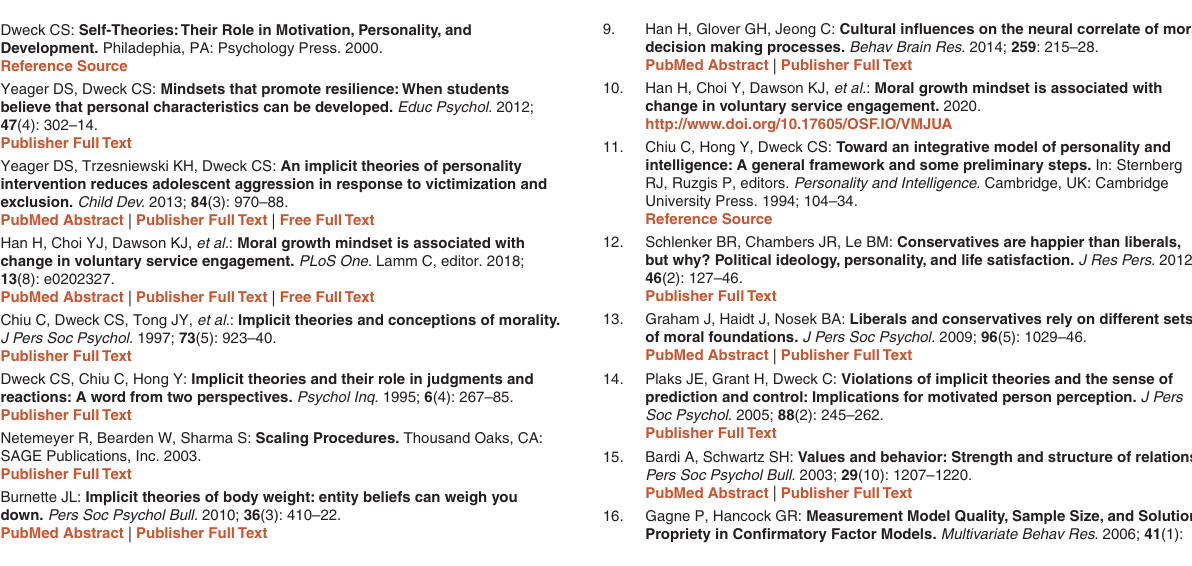
• Supplementary Table.xlsx - Supplementary table report- ing factor loadings from 6-item and 5-item models (contained in folder ‘English version MGM’,